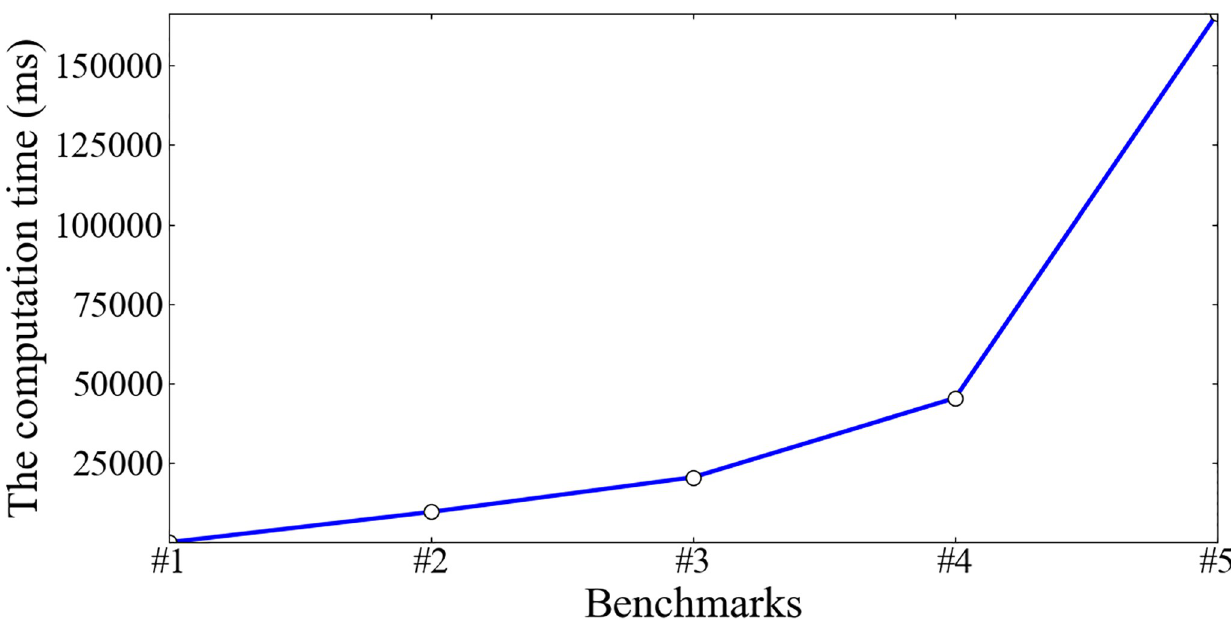
Fig 2. The computation costs in the Outsource phase